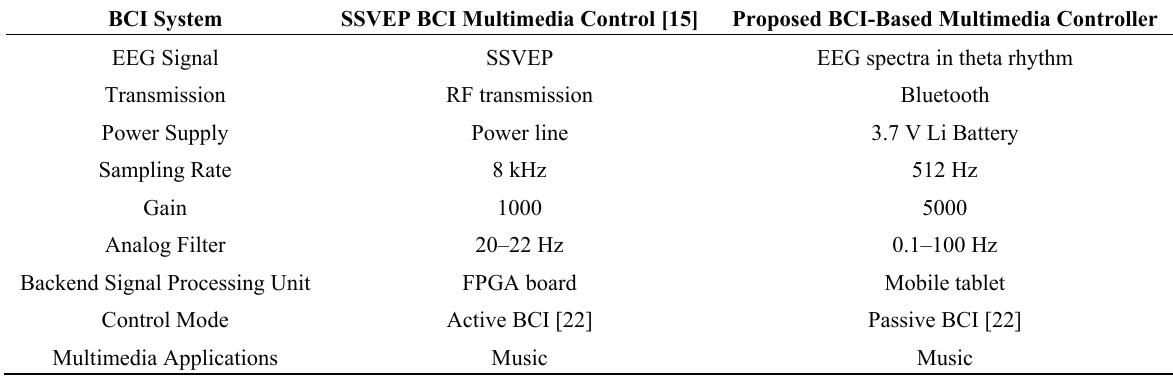
Table 1. Specification comparison between proposed system and other BCI-based multimedia